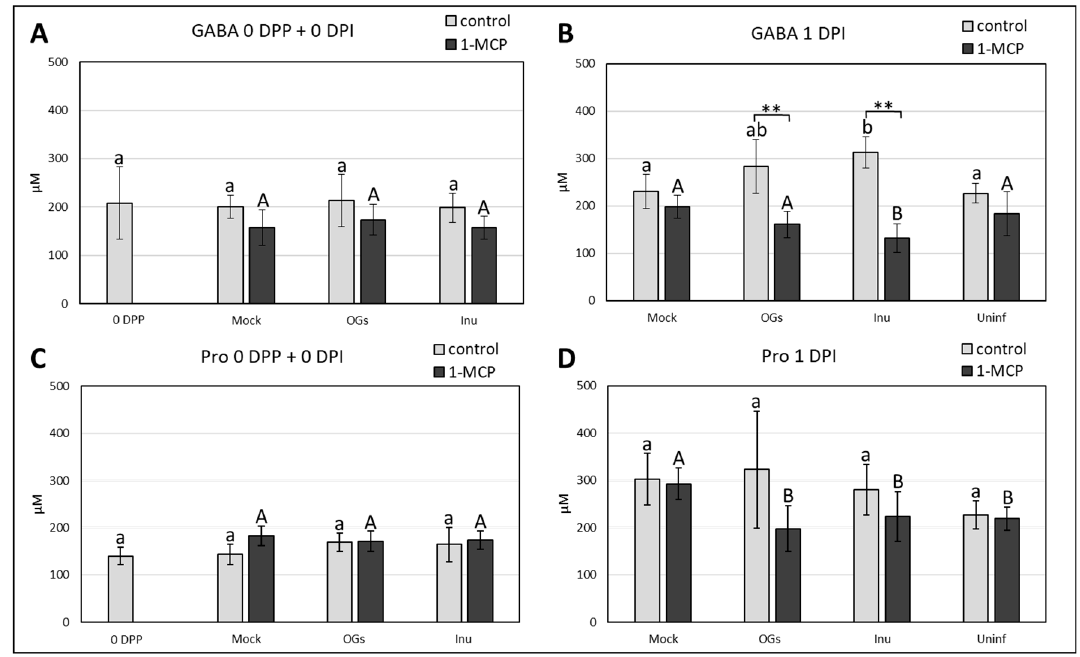
Figure 8. γ -Aminobutyric acid (GABA) and Pro in primed and 1-MCP treated samples. Mock = water-primed leaves; OGs = OGs-primed leaves; Inu = chicory inulin-primed leaves; Uninf = Water-primed leaves inoculated with a mock solution (1/2 strength Potato dextrose broth). ( A ) GABA levels at 0 DPP and 0 DPI; ( B ) GABA levels at 1 DPI; ( C ) Pro levels at 0 DPP and 0 DPI; ( D ) Pro levels at 1 DPI. Bars marked with same letter(s) are not significant between each other, bars that have no letters in common indicate significance between treatments ( p < 0.05, one-way ANOVA followed by Tukey’s post-hoc test). Lowercase letters refer to comparison between control treatments, capital letters refer to comparison between 1-MCP treatments. Asterisks indicate significance between control and 1-MCP conditions referring to the same priming treatment (** p < 0.01, Student’s t -test). Values represent the average ± standard deviation of five biological replicates.